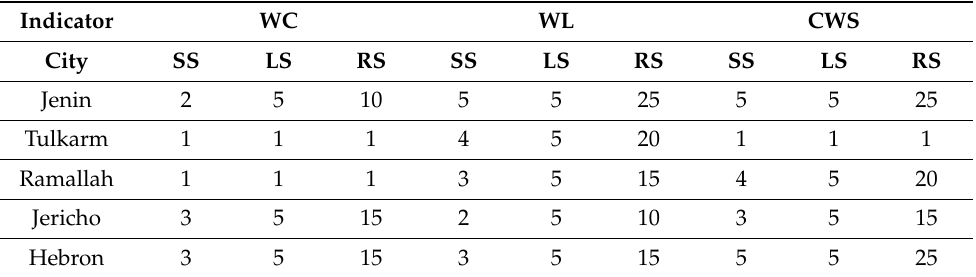
Table 18. Risk score (RS) for water coverage (WC), water losses (WL) and the continuity of the water supply (CWS).